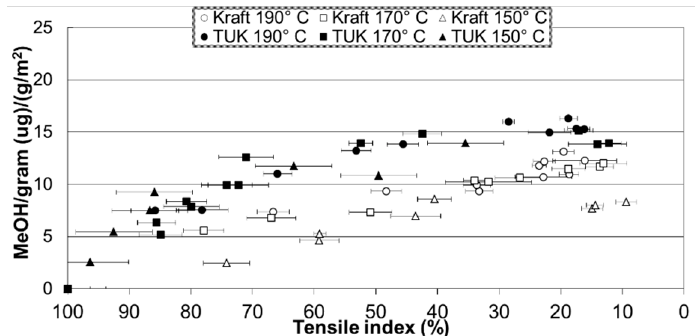
Figure 6. Tensile index of paper samples versus concentration of methanol normalized by paper grammage, from [30].